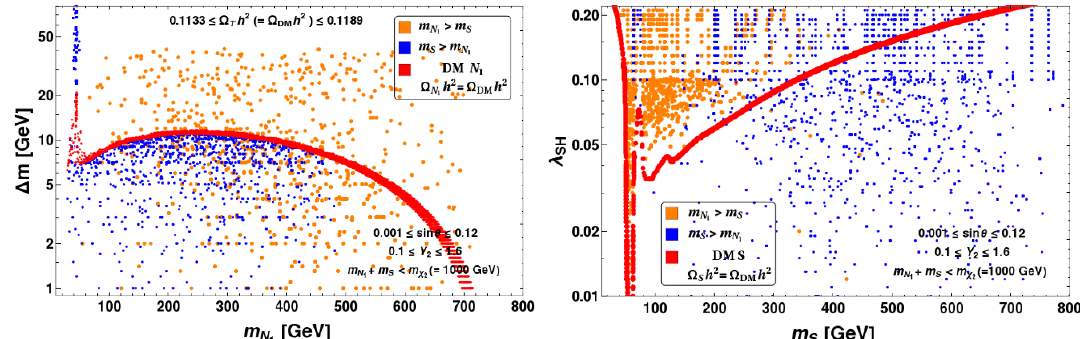
Figure 15 . Total relic density allowed regions of two component DM model in m N panel) and m S (cid:21) SH plane (right panel) with Y 2 (cid:0) mass hierarchies are shown in di(cid:11)erent colour codes: m N (blue points). Red points correspond to the case of single component DM scenarios for N 1 on left and for S on right